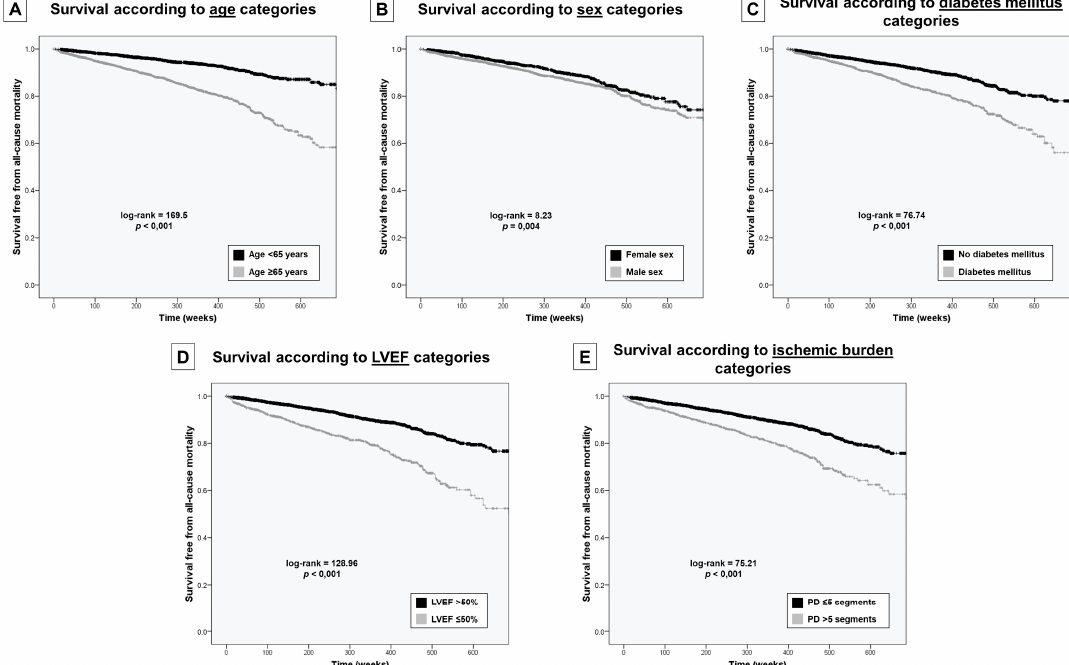
Figure 2. Kaplan–Meier curves to predict the risk of all-cause mortality according to the independent predictors in multivariable analysis. ( A ) Curves according to age categories ( < 65 and ≥ 65 years). ( B ) Curves according to sex categories (male and female). ( C ) Curves according to diabetes mellitus categories (with and without). ( D ) Curves according to LVEF categories ( > 50% and ≤ 50%). ( E ) Curves according to ischemic burden on stressCMR categories ( ≤ 5 and > 5 segments with PD). Abbreviations: LVEF = Left ventricular ejection fraction. stressCMR = Vasodilator stress cardiac magnetic resonance. PD = Perfusion defects on